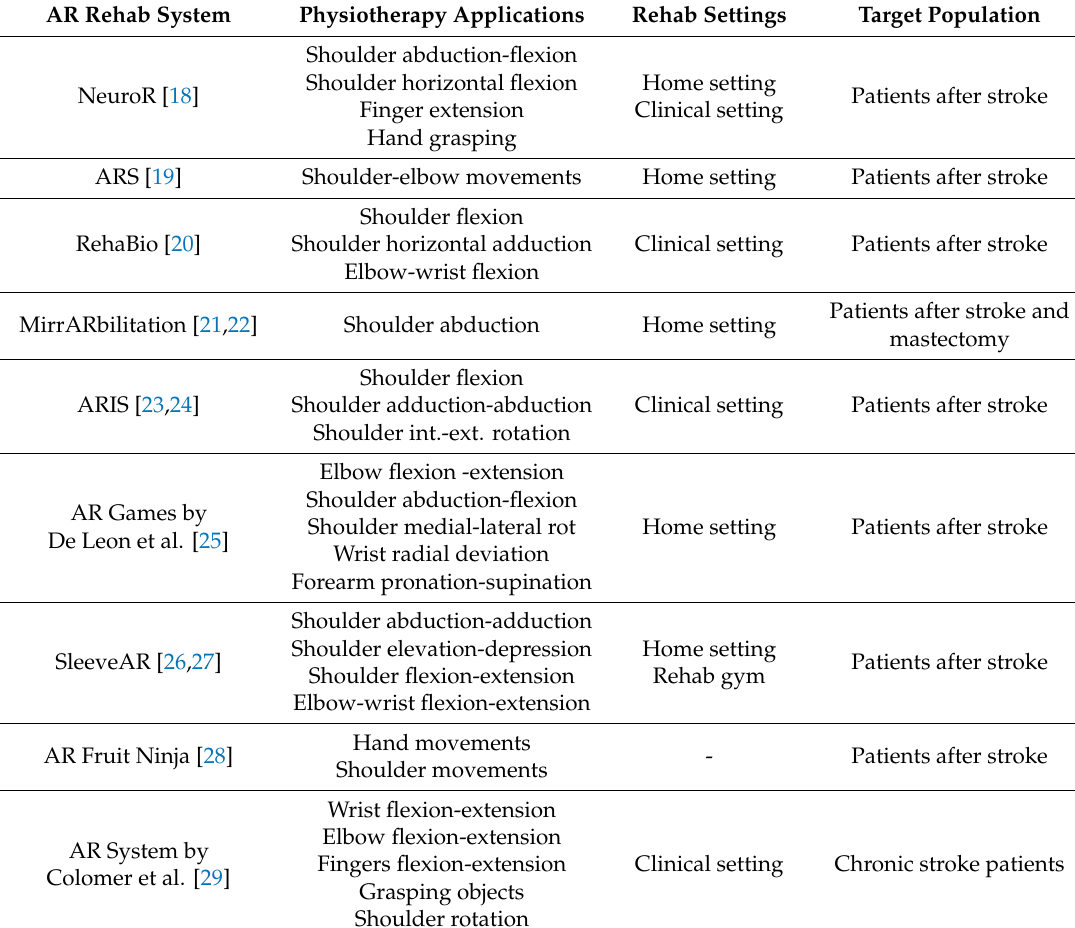
Table 1. A summary of the AR-based systems for shoulder rehabilitation, reviewed in this